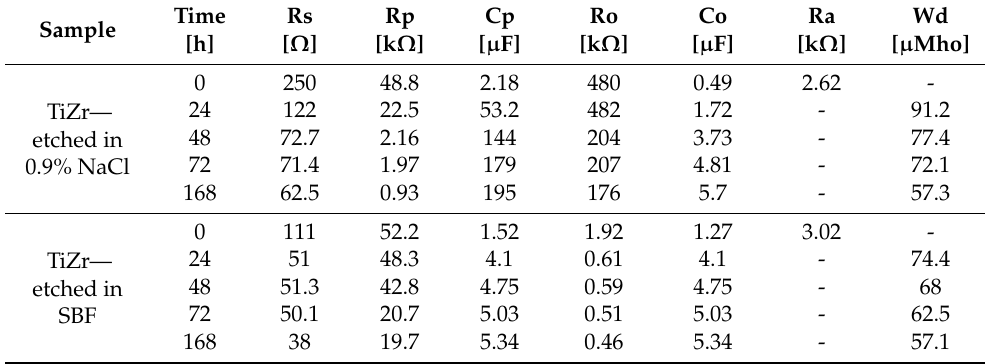
Table 4. Equivalent circuit values for etched TiZr covered with PLA nanofibers in 0.9% NaCl and SBF.